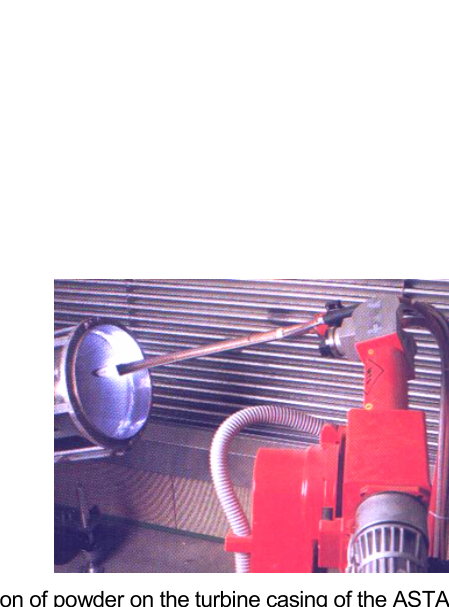
Figure 1 – Deposition of powder on the turbine casing of the ASTAZOU III B turbo-jet engine Рис . 1 – Нанесение порошка на корпус турбореактивного двигателя Нанесение порошка на корпусе турбины в B турбореактивных Astazou